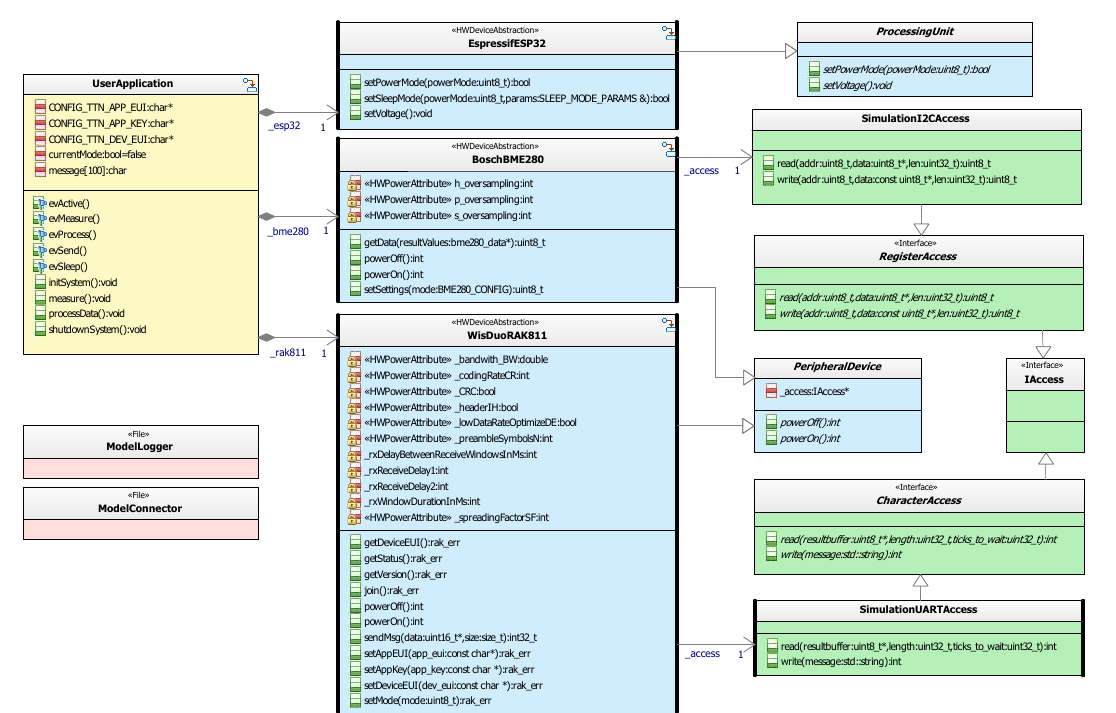
Figure 18. Class diagram of the software application of the beehive microclimate sensor node modeled in IBM Rhapsody. The main class is highlighted in yellow. Blue-colored Classes represent hardware component models, while communication interfaces are marked green. Classes highlighted in red are used to extend the simulation environment and provide data exchange for external tools.